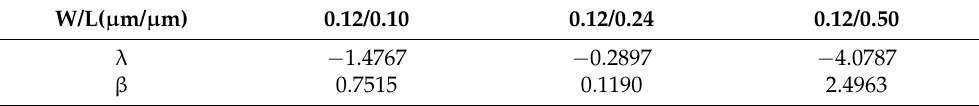
Table 4. Extracted λ and β parameters under V DS = V GS – V T = 1~1.2 V with multi-fin. W/L( µ m/ µ